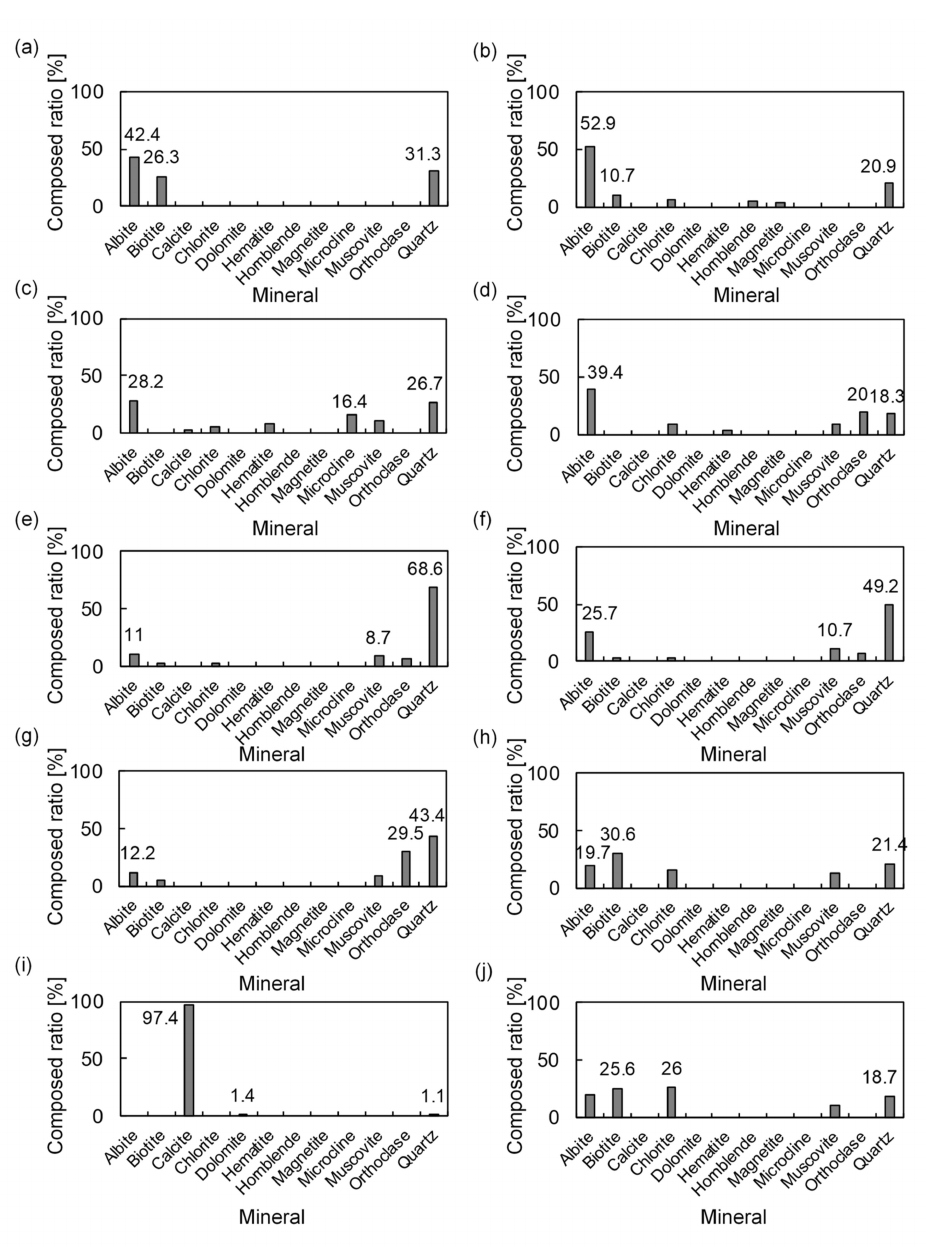
Figure 5. Ratio of minerals within each sample: ( a ) albite 1, ( b ) albite 2, ( c ) albite 3, ( d ) albite 4, ( e ) quartz 1, ( f ) quartz 2, ( g ) quartz 3, ( h ) biotite, ( i ) calcite, and ( j )